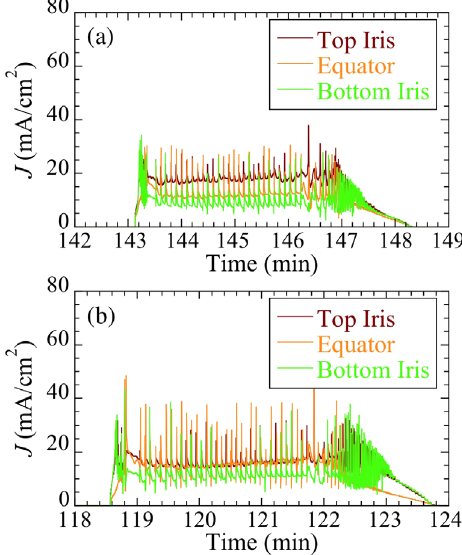
FIG. 16. Coupon currents in the top cell with single flow and dual flow at a cathode rotation of 0 rpm, cavity temperature of ∼ 15 °C, and total flow rate of 15 L = min. (a) Single flow at 15 L = min and (b) dual flow at 5 L = min in the cavity and 10 L = min in the cathode